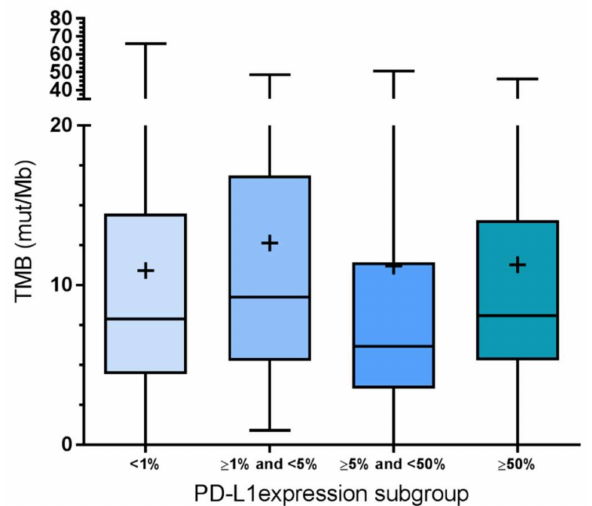
Figure 5. TMB is not di ff erent in the four groups of the PD-L1 tumor proportion score. Data are presented as box plots with a 95% confident interval. The line indicates the mean, the + indicates the median. Statistical analysis by ANOVA did not reveal significant ( p < 0.05) di ff erences in TMB between TPS